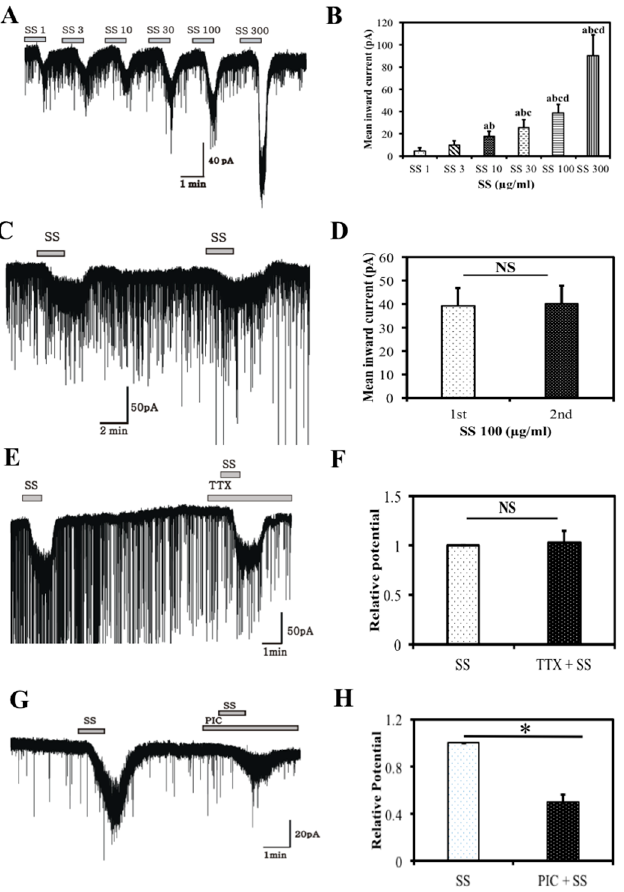
Figure 8. Effect of Stachys sieboldii on juvenile CA1 neuron. Concentration-dependent increase in SS-induced inward currents ( A ) and bar graph of Figure A ( B ). Reproducible non-desensitizing effect of SS (100 µ g/mL) on a juvenile CA1 neuron ( C ), Bar graph shows the mean relative inward currents induced by SS (100 µ g/mL) ( D ). The SS-induced inward currents persisted in the presence of TTX (0.5 µ M) ( E ). Bar graph shows the mean inward currents by SS ( F ). The SS-mediated inward currents occurred partly through the extrasynaptic GABA A receptors. A current trace of a juvenile CA1 neuron held at − 60 mV, showing presence of slight outward shift in the picrotoxin, ( G ) which got intensified in the presence of SS, ( H ) bar graphs show the mean outward current by PIC alone and PIC in the presence of SS. All values are mean ± S.E.M. ( n = 5). * Mean with different superscripts in the same row such as a, b, * indicates significant difference among the groups. One-way ANOVA was performed to analyze more than two experimental groups using origin 7.0. Student’s t -test was used to examine the differences between the two experimental groups. p < 0.05 was considered significant.